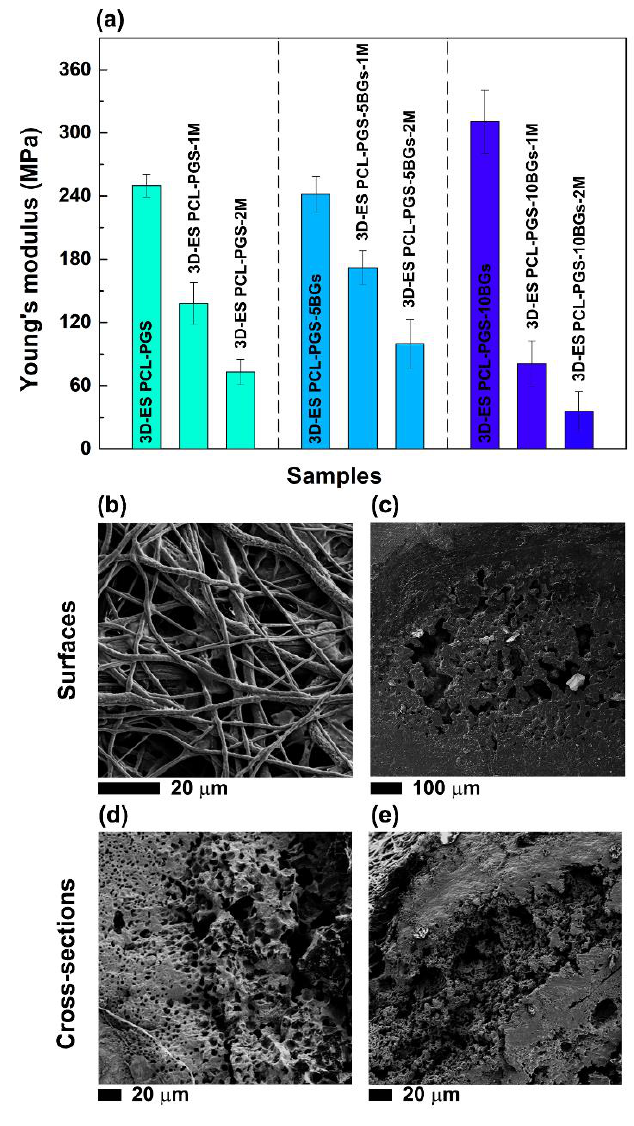
Figure 6. ( a ) Values of Young’s modulus of the composite scaffolds after one month (3D-ES PCL-PGS-1M, 3D-ES PCL-PGS-5BGs-1M, 3D-ES PCL-PGS-10BGs-1M) and two months (3D-ES PCL-PGS-2M, 3D-ES PCL-PGS-5BGs-2M, 3D-ES PCL-PGS-10BGs-2M) of incubation in PBS at 37 °C. SEM images, after 2 months degradation, of the surface ( b ) of the electrospun layer and ( c ) 3D-printed one; ( d ) and ( e ) the cross-section of the 3D-printed layer.